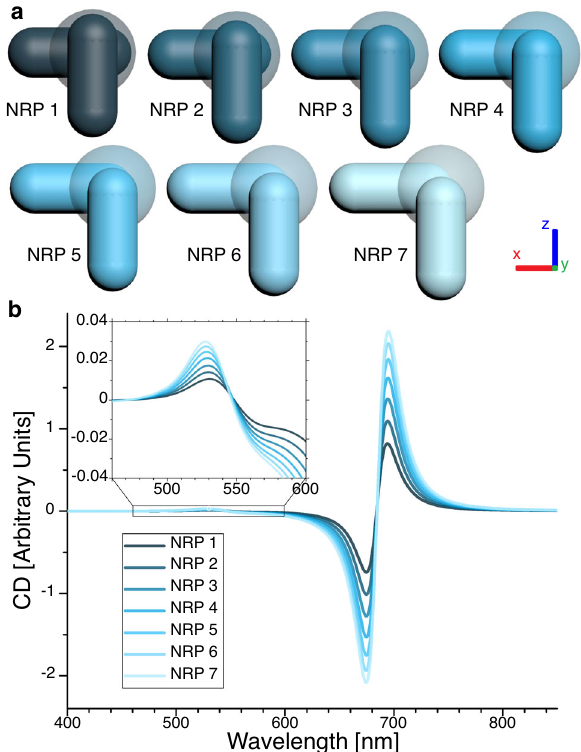
Fig. 4 CD intensity depends critically on nanoparticle position. a Slightly varying nanorod positions (NRP) are exempli fi ed for the NR – NS – NR assemblies. In each step, the lower NR is shifted 2 nm in x -direction and the upper NR is shifted 2 nm in negative z -direction. b Simulated CD signals of NR – NS – NR assemblies in NRP 1 – 7, starting with a weak signal for NRP 1 and ending with a much stronger signal for NRP